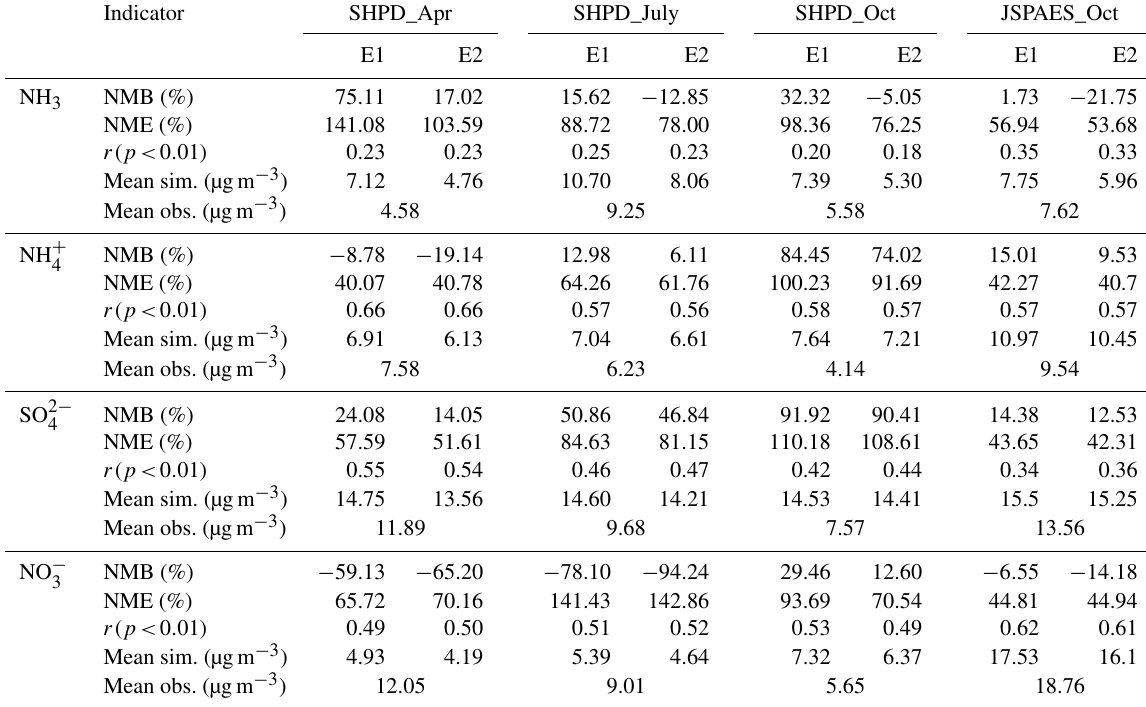
Table 3. Model performance statistics for the hourly concentrations of NH 3 and SIA from observation and CMAQ simulation with the two inventories at the SHPD and JSPAES sites for available months.